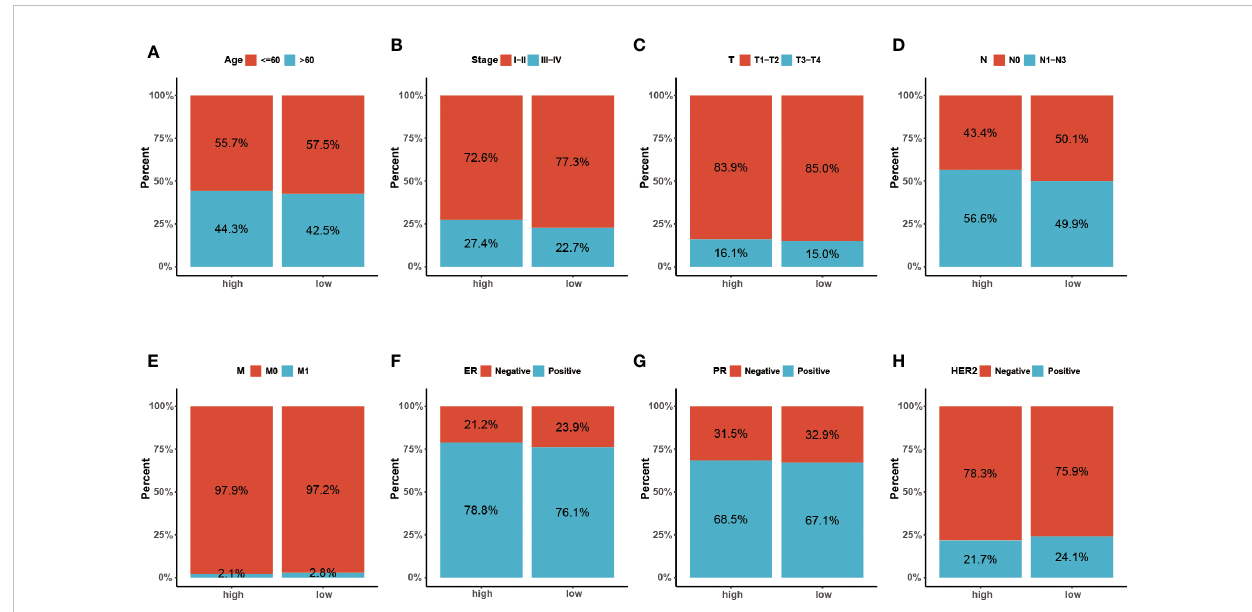
FIGURE 5 (A-H) The distribution characteristics of different clinicopathological factors in the two risk groups (Age, Stage, T, N, M, ER, PR and HER-2,